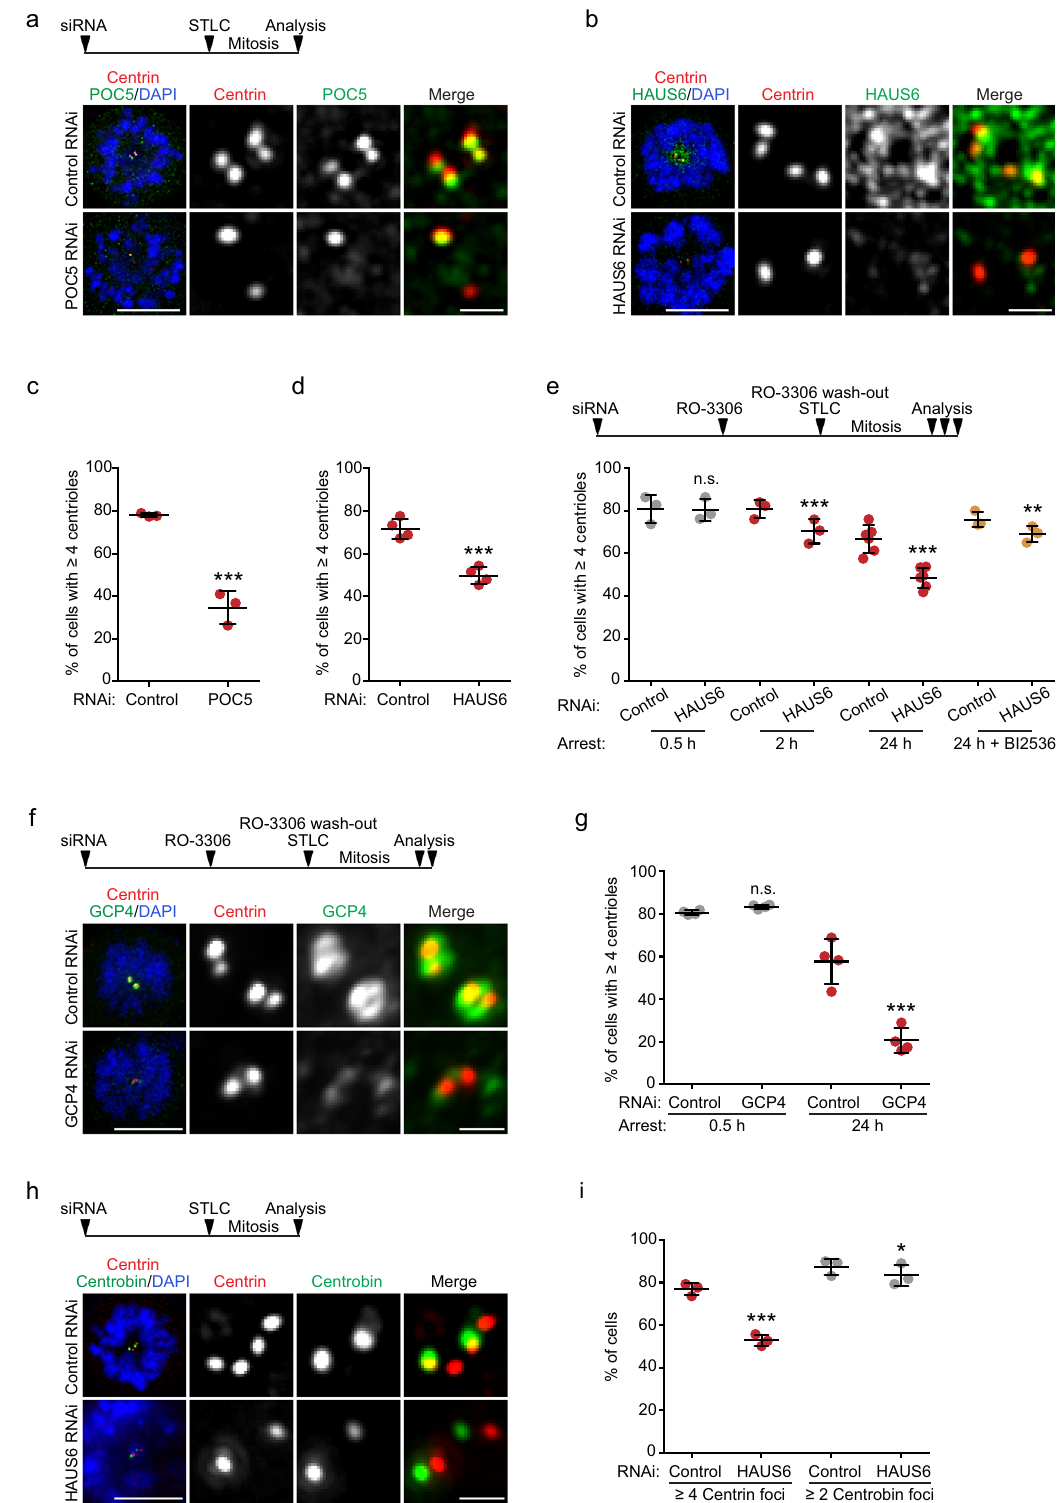
Cell culture treatments and assays . Microtubule regrowth assay (Fig. 1b): cells grown on coverslips were incubated on ice for 40 min to depolymerize cytoplasmic microtubules. For microtubule regrowth, coverslips were transferred into 3.7% paraformaldehyde at 37 °C for 1min, followed by the incubation in methanol